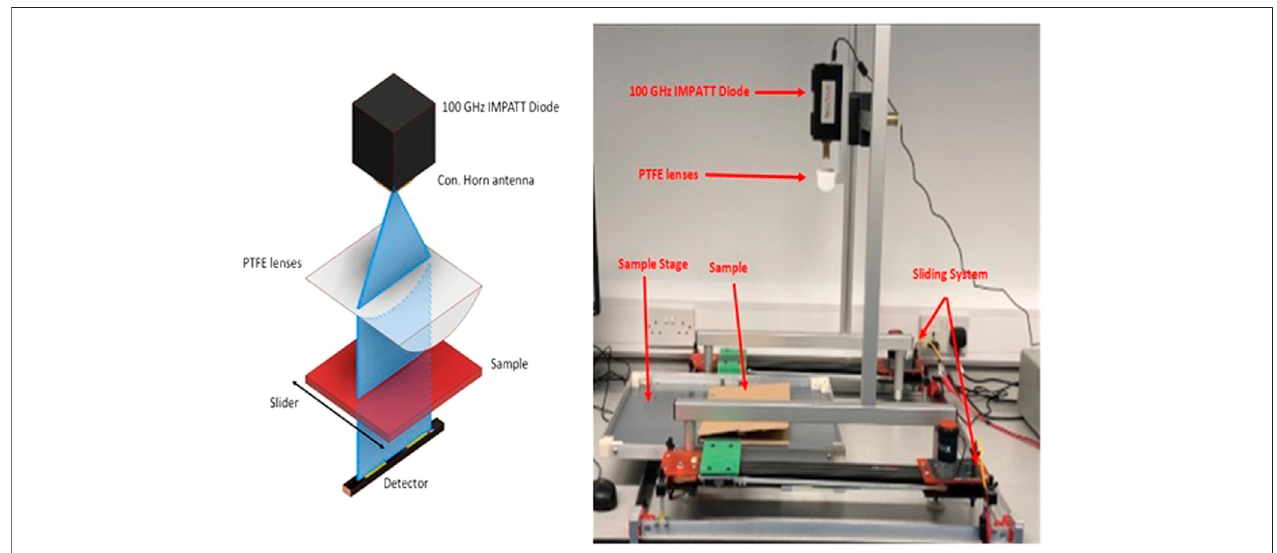
FIGURE 1 | (Left) Schematic plot of 100 GHz line scanner (Right) photograph of the Line